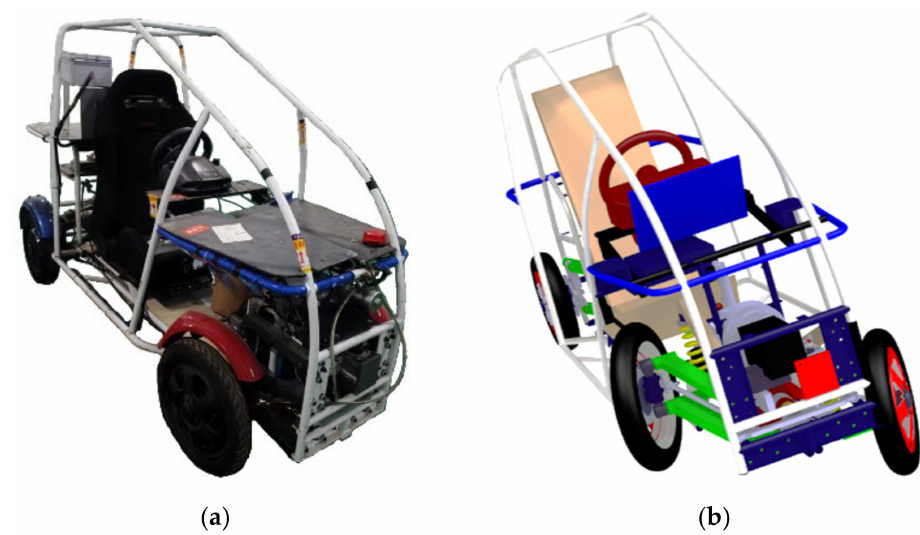
Figure 1. The narrow tilting vehicle: ( a ) the physical; ( b ) the structural